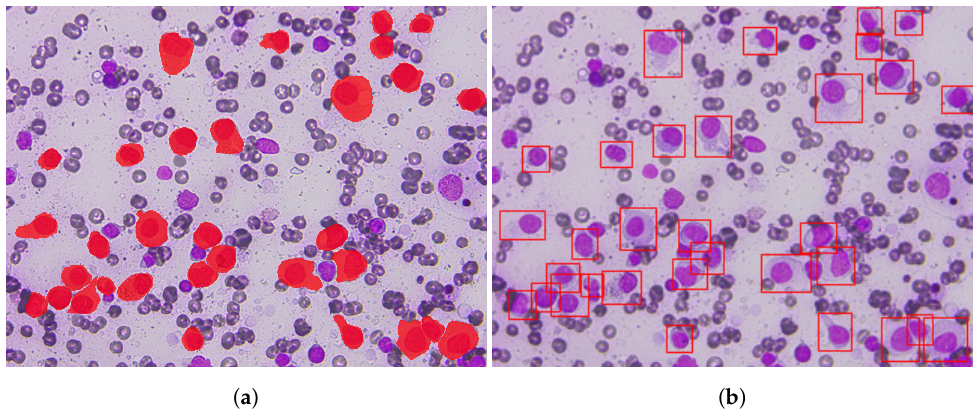
Figure 7. Conversion of the image from the segmentation dataset for the detection experiments. ( a ) Segmentation polygons. ( b ) Detection frames.